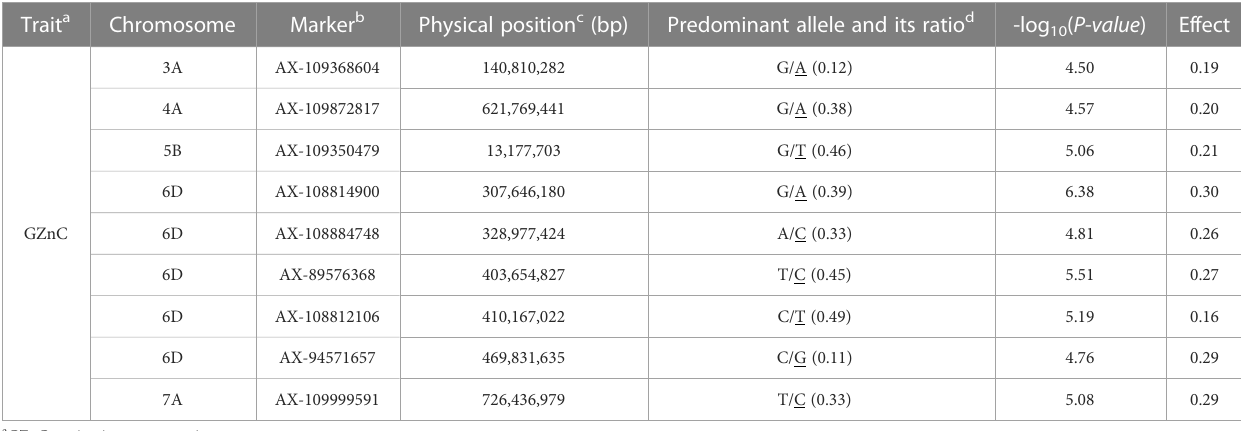
TABLE 4 Signi fi cant QTLs associated with